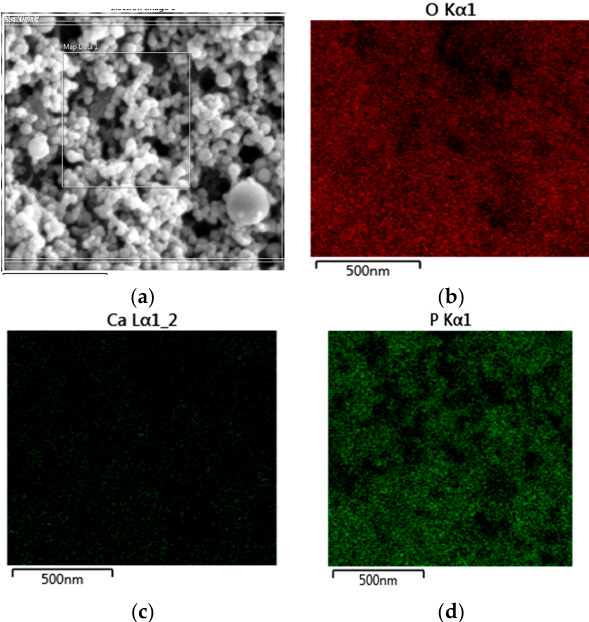
Figure 2. EDX elemental mapping of the HA nanoparticles ( a ) showing evidence of oxygen ( b ), calcium ( c ), and phosphorus ( d ) in the hydroxyapatite samples.